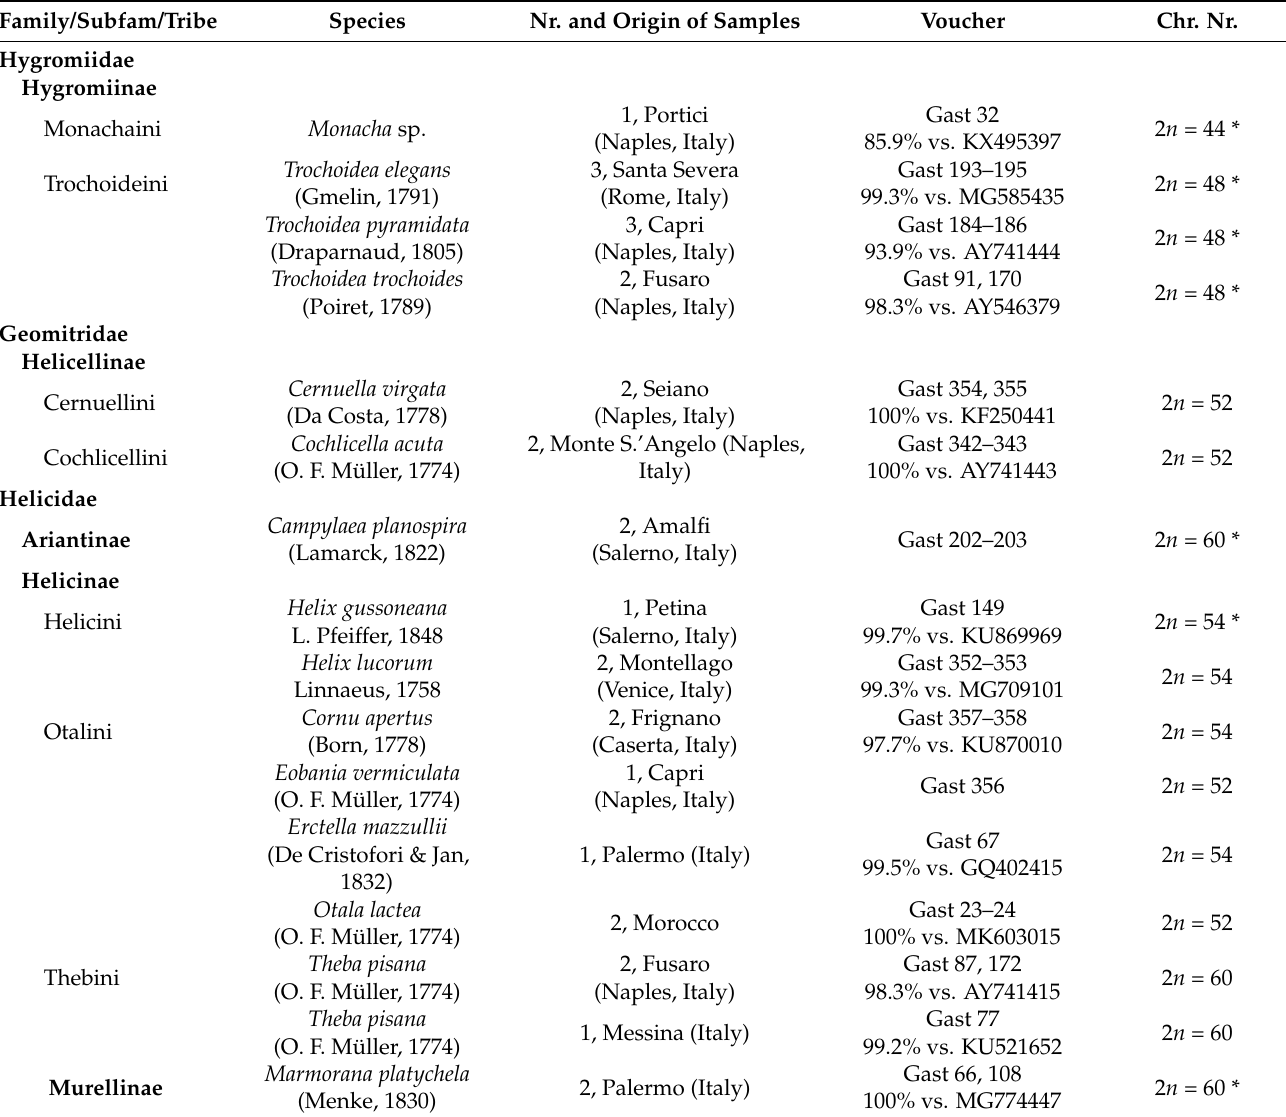
Table 1. Number and provenance of the examined specimens of Helicoidae. Biological samples (methanol and acetic acid fixed cell suspensions) are deposited in the Molluscan collection of the Department of Biology, University of Naples Federico II. * Present study; Chr. Nr = chromosome number. Species Nr. and Origin of Samples Voucher Chr.